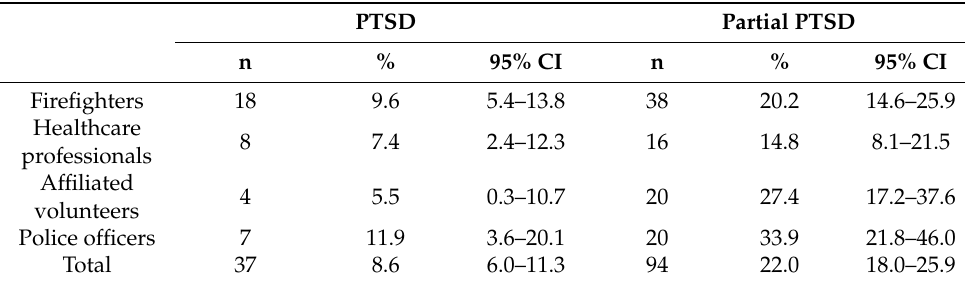
Table 1. Prevalence of PTSD and partial PTSD by first responder category in wave 2, n = 428. PTSD Partial